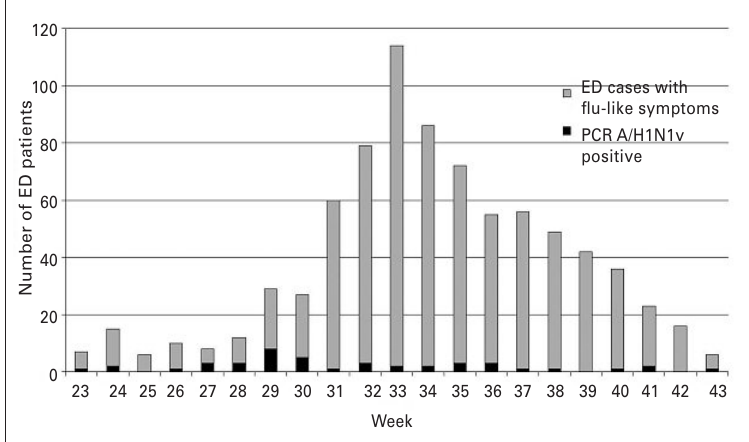
Figure 2 Epidemiology of patients presenting to the ED with flu-like symptoms.